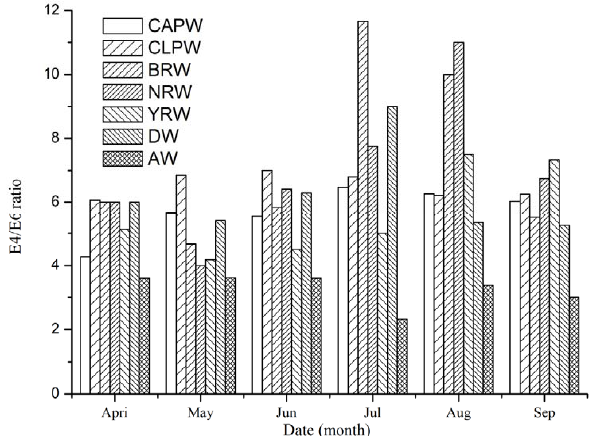
Fig. 5. Monthly E4/E6 ratios in surface ponds from contrasting wet- land ecosystems in the Sanjiang Plain during the growing season of 484 485 486